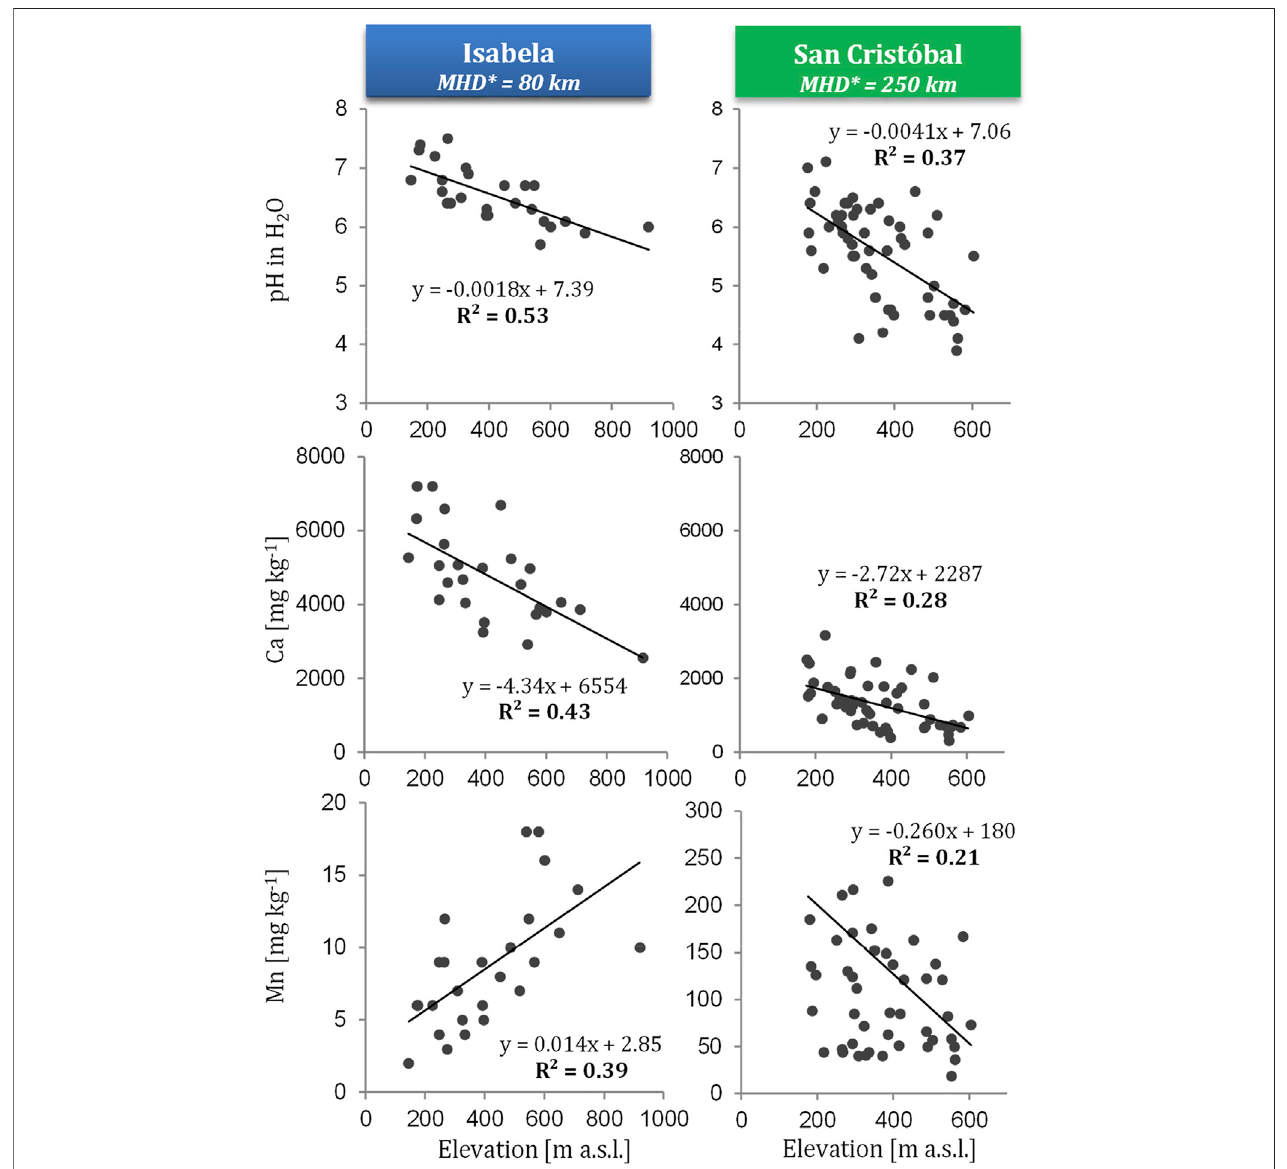
FIGURE4| Altitudinaltrends in soil pHand Mehlich(III)-extractableCa and Mn for theislands Isabela and San Cristóbal. MHD (cid:1) meanhotspot distance (horizontal distance of sampling points from the hotspot center as estimated by Hooft et al., 2003); m a.s.l. (cid:1) meters above sea level.